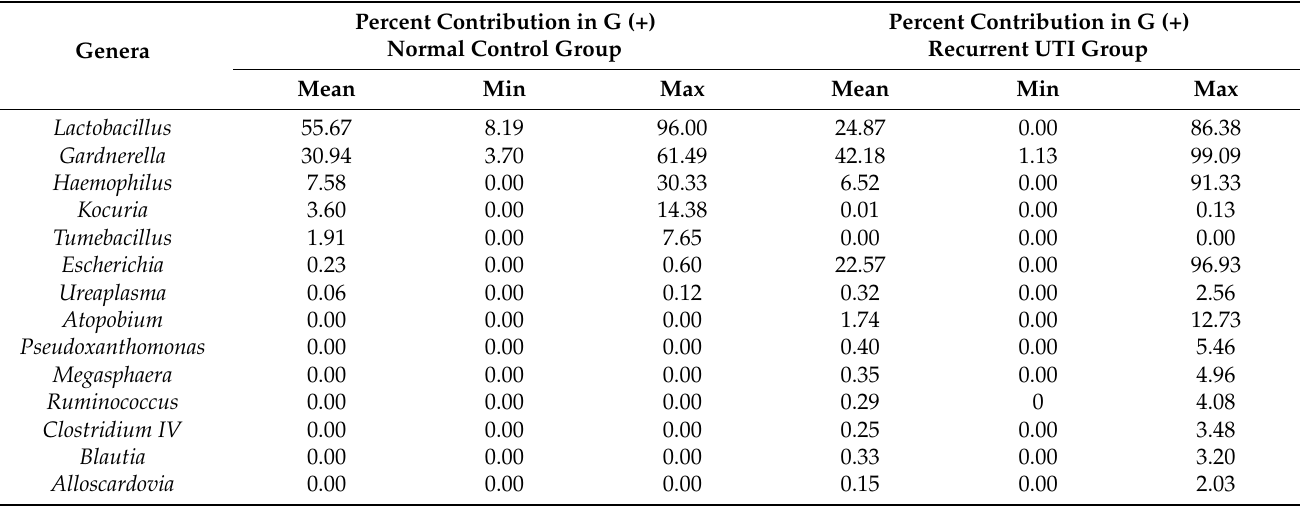
Table 3. Contribution of most abundant urinary bacterial genera to Gardnerella positive